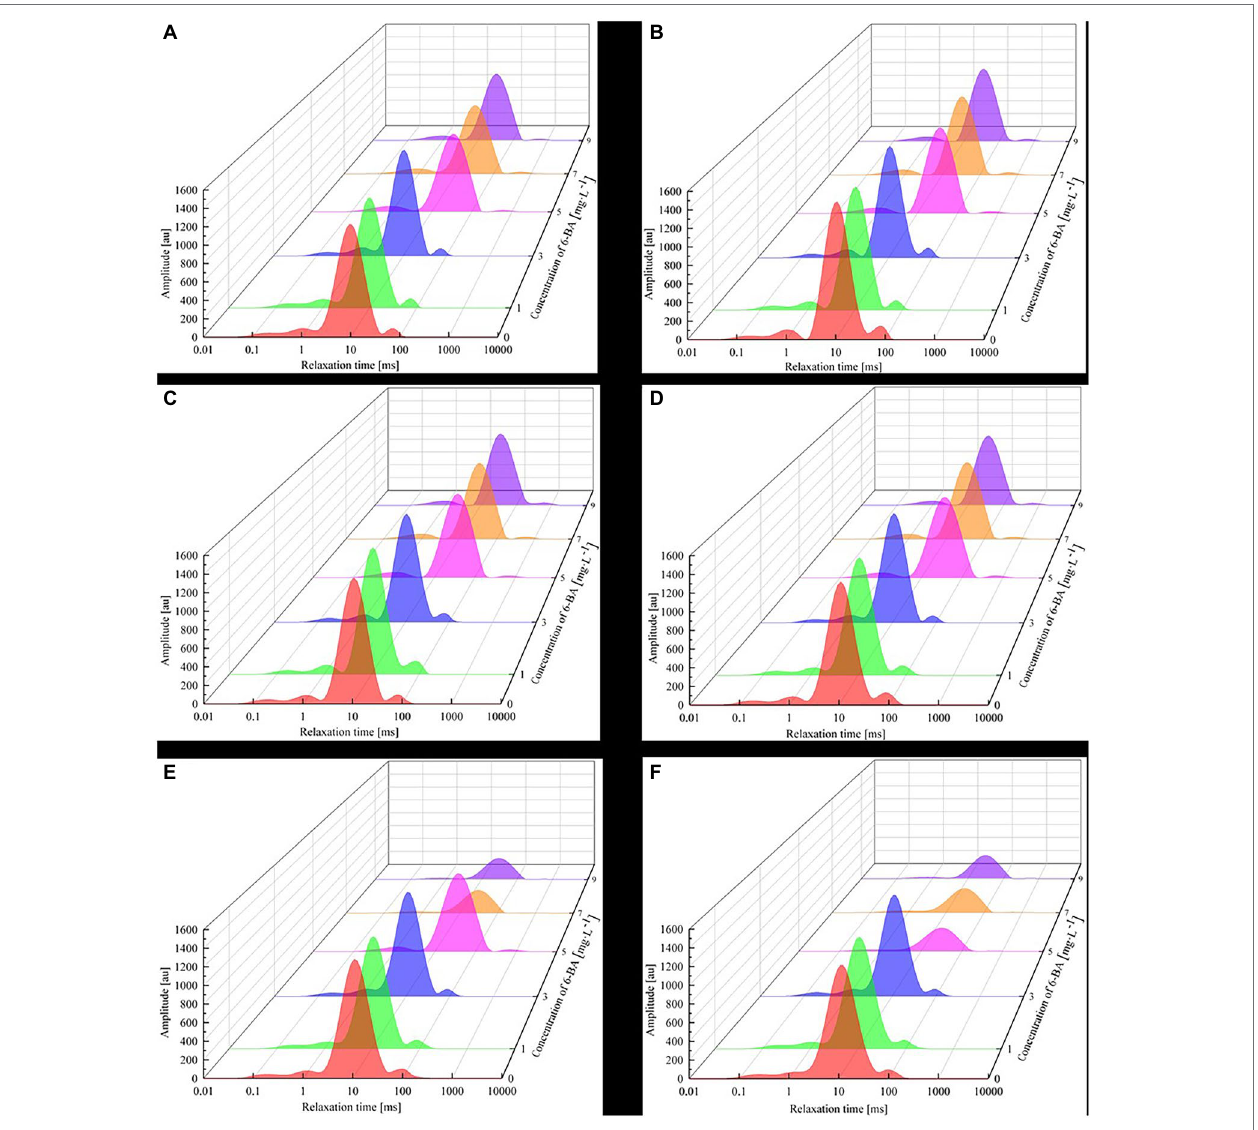
FIGURE 4 | LF-NMR T 2 relaxation time inversion spectrum waterfall of different germination times for different 6-BA concentrations: (A) soaking for 8 h, (B) germination for 12 h, (C) germination for 24 h, (D) germination for 36 h, (E) germination for 48 h, and (F) germination for 60 h. The experimental environment was as follows: temperature, 25 ° C; relative humidity, 50%; germination time, 0–60 h. The T 2 relaxation time was determined using the CPMG sequence with the following parameters: SF, 21 MHz; SW, 200 kHz; TE, 0.25 μ s; P1, 16 μ s; P2, 36 μ s; TW, 2000 μ s; RFD, 0.02 ms; RG1, 20 db; DRG1, set to 3; and NECH,